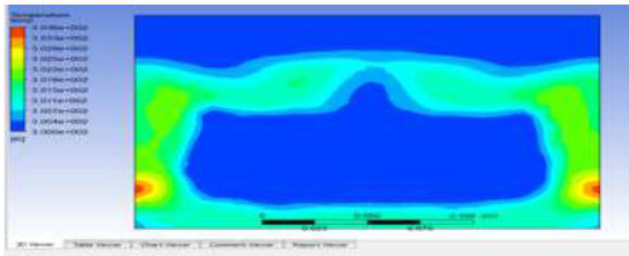
Figure 10: Temperature distribution at outlet for Circular shape